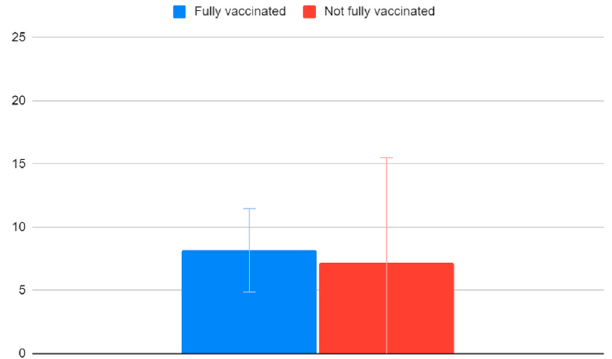
Figure 7. VACS values and vaccination history.